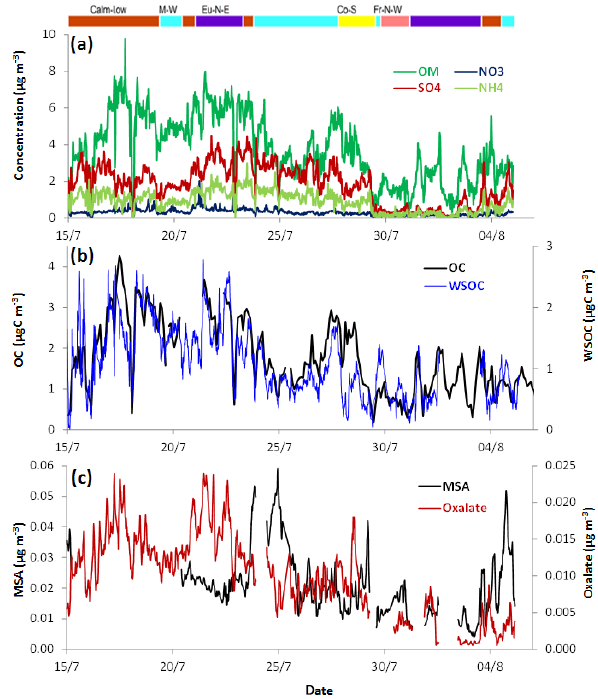
Figure 5. Temporal variability at Cape Corse in (a) submicron (NR- PM 1 ) chemical constituents measured by ACSM. (b) OC (PM 2 . 5 ) and WSOC (PM 1 ) measured by OCEC Sunset field instrument and PILS-TOC. (c) MSA and oxalate (PM 10 ) measured by PILS-IC. The colored areas at the top correspond to back-trajectory clus- ters: light blue, purple, yellow, pink and orange-brown for the ma- rine west (M-W), Europe northeast (Eu-N-E), Corsica south (Co-S), France northwest (Fr-N-W) and calm low wind (calm-low) clusters,